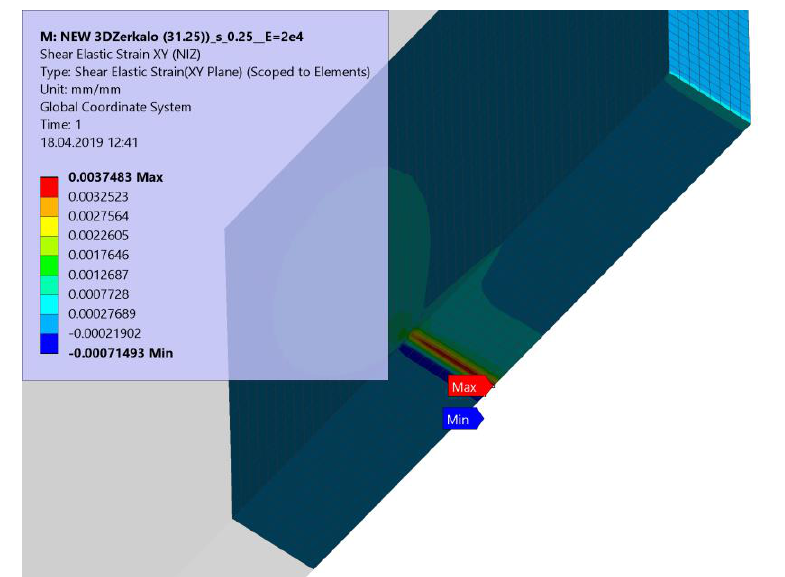
Fig. 5. Distribution of angular deformations γ xy in the lower part of the deep beam